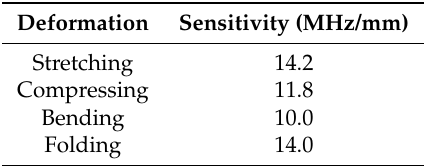
Figure 5. Resonant frequency shift of the spiral fiber antenna in free space as a function of the induced stretching ( a ), compressing ( b ), bending ( c ), and folding ( d ) deformations. Table 1. The antenna fiber’s sensitivity for each induced